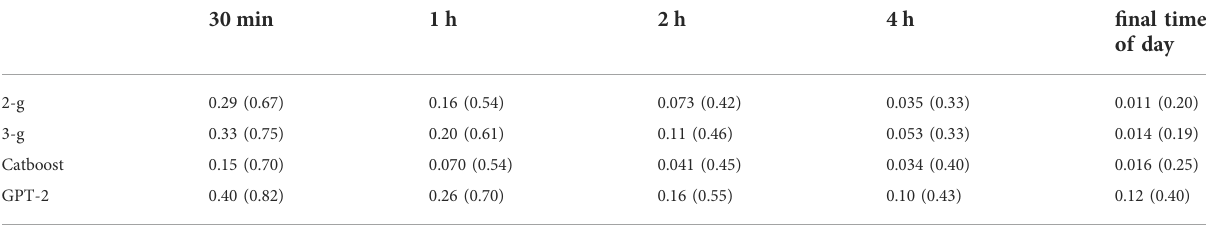
TABLE 1 Probability that the prediction is within 1 km (10 km) of the actual location coordinates for the next half hour, one hour, two hours, four hours, and the fi nal time of the day. We performed 24,247 realizations of each model to estimate the probabilities.